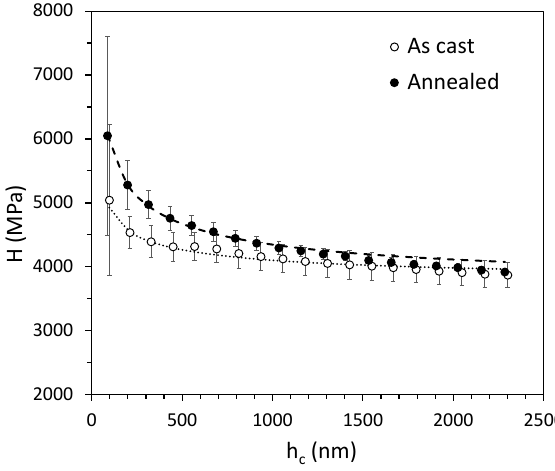
Figure 5. Comparison of depth dependence of the hardness in the as cast and annealed